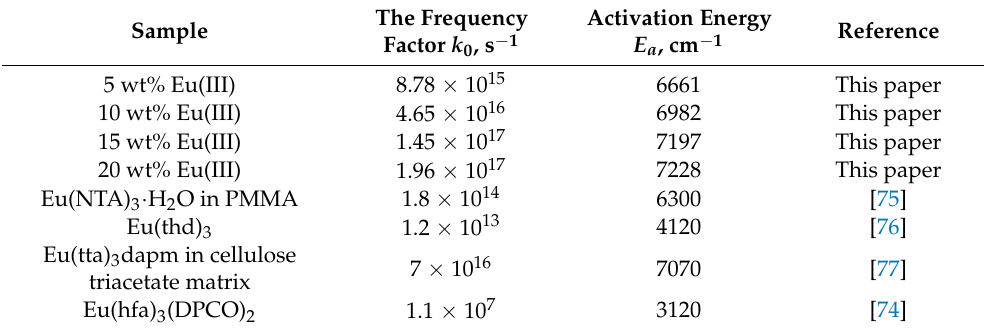
Table 2. The frequency factor and activation energies of the PLA composite films doped with different amounts of the Eu(III) complex and similar compounds.